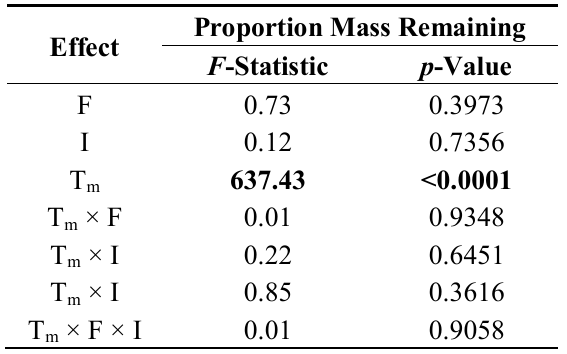
Table 5. F -Statistic and p -value for treatment and interaction effects on the proportion of mass remaining for the simulated disturbance forest floor decomposition experiment.